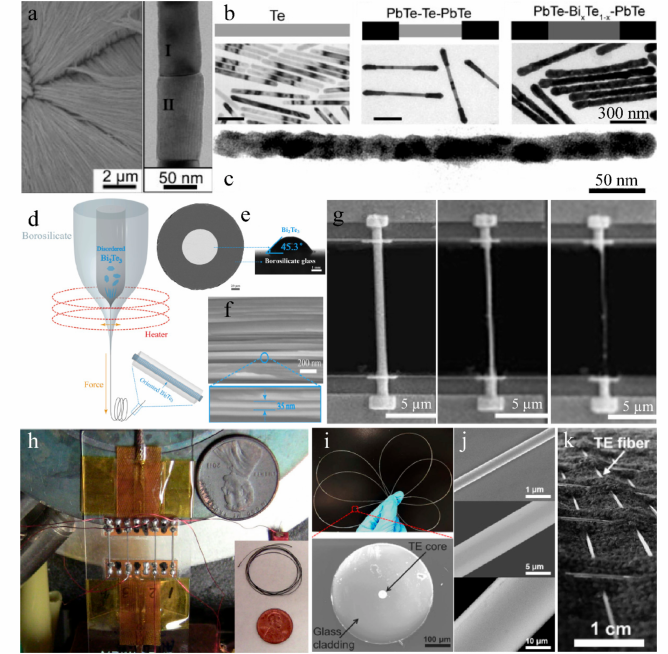
Figure 1. ( a ) Scanning electron microscopy (SEM) images of the Bi 2 Te 3 /Te multisegmented